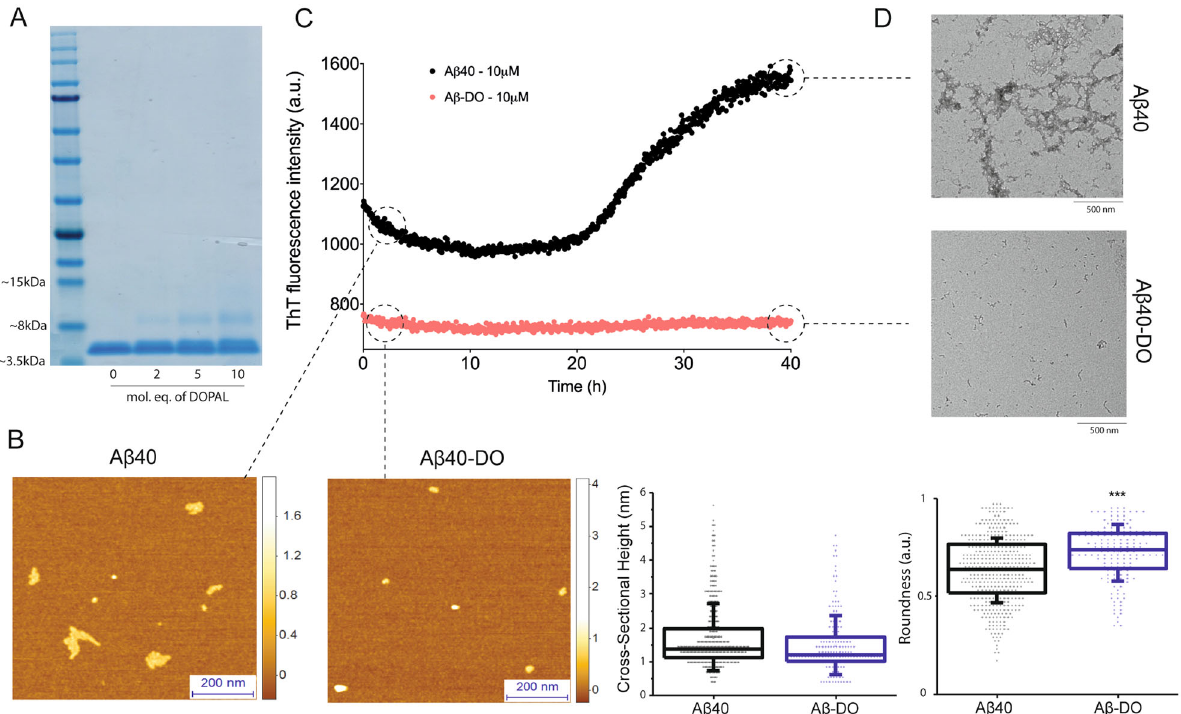
Fig. 3 Biophysical characterisation of DOPAL-induced stable A β 40 oligomers (A β -DOs). a SDS-page analysis of the pellet fraction of A β 40 after 20 h of incubation with increasing concentrations of DOPAL. b – d Morphologies and stability measurement of A β 40-noDOs and A β -DOs. b Representative 3D morphology maps measured by AFM of preformed A β 40-noDOs and A β -DOs, with their cross-sectional height and roundness distributions as collected from a . c ThT-based stability measurements of A β 40-noDOs and A β -DOs over the course of 40 h. d TEM images of the samples in b , after 40 h of incubation at 37 °C. Note the distinct fi brillised samples of A β 40-noDOs after the stability measurement, which is otherwise absent in the A β 40-DOs samples. For fi gures b , c and d , assays were performed using the sample containing 10 molar equivalents of